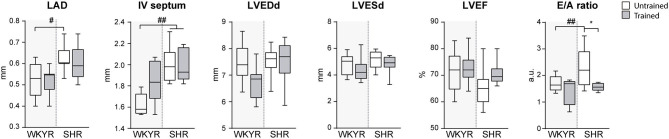
Ecochardiographic evaluation after completing the 8-week training period. LAD, Left atrial diameter; IV septum, Interventricular septum, LVEDd, Left ventricular end-diastolic diameter; LVESd, Left ventricular end systolic diameter; LVEF, Left ventricular ejection fraction; E/A ratio, Trans-mitral E wave/A wave ratio. Groups: WYKR untrained (n = 8), WYKR trained (n = 8), SHR untrained (n = 10) and SHR trained (n = 10). All values are mean ± SD. Statistical significance was calculated using ANOVA, and group comparisons were performed using Tukey's test. *p < 0.05 untrained vs. trained group, #p < 0.05 WKYR vs. SHR and ##p < 0.01 WKYR vs. SHR.